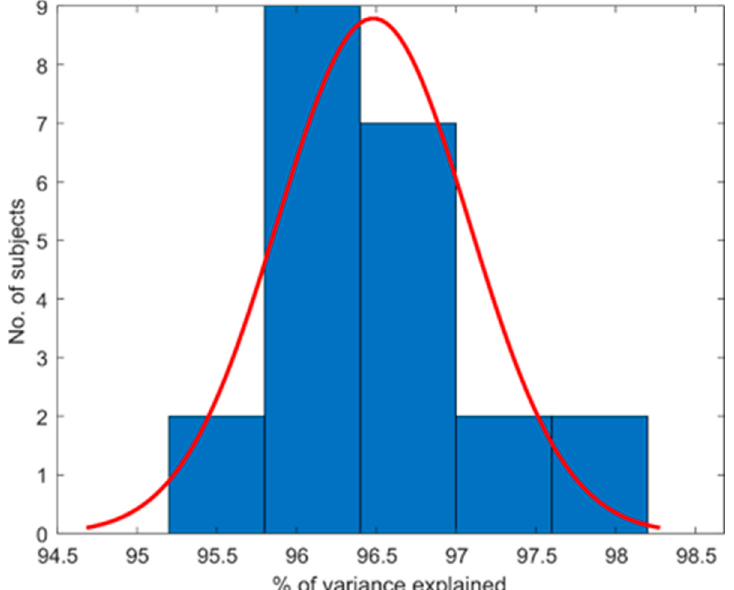
Figure 3. Total amount of variance explained per subject.